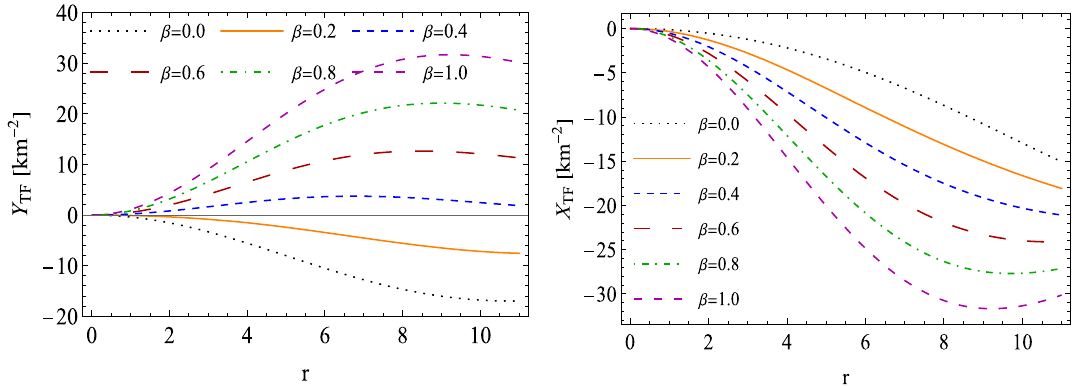
Fig. 6 Left panel and Right panel show the behavior of complexity factor ( Y TF × 10 4 ) and density inhomogeneity X TF × 10 4 versus r , respectively for different β for isotropic solution 5.2. We set same numerical values as used in